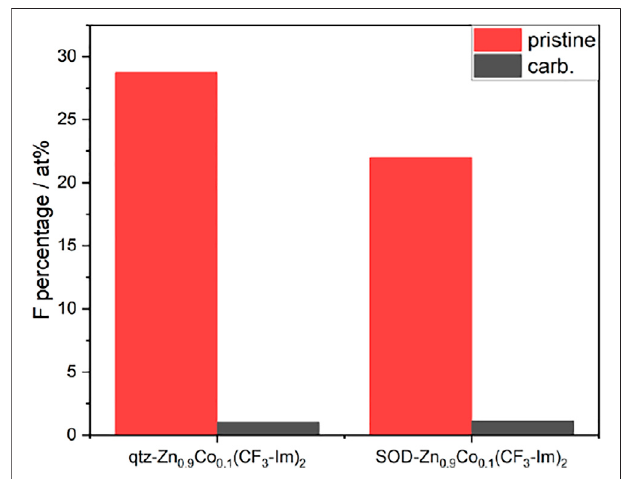
FIGURE 9 | Fluorine content of pristine (red) and carbonized (grey)